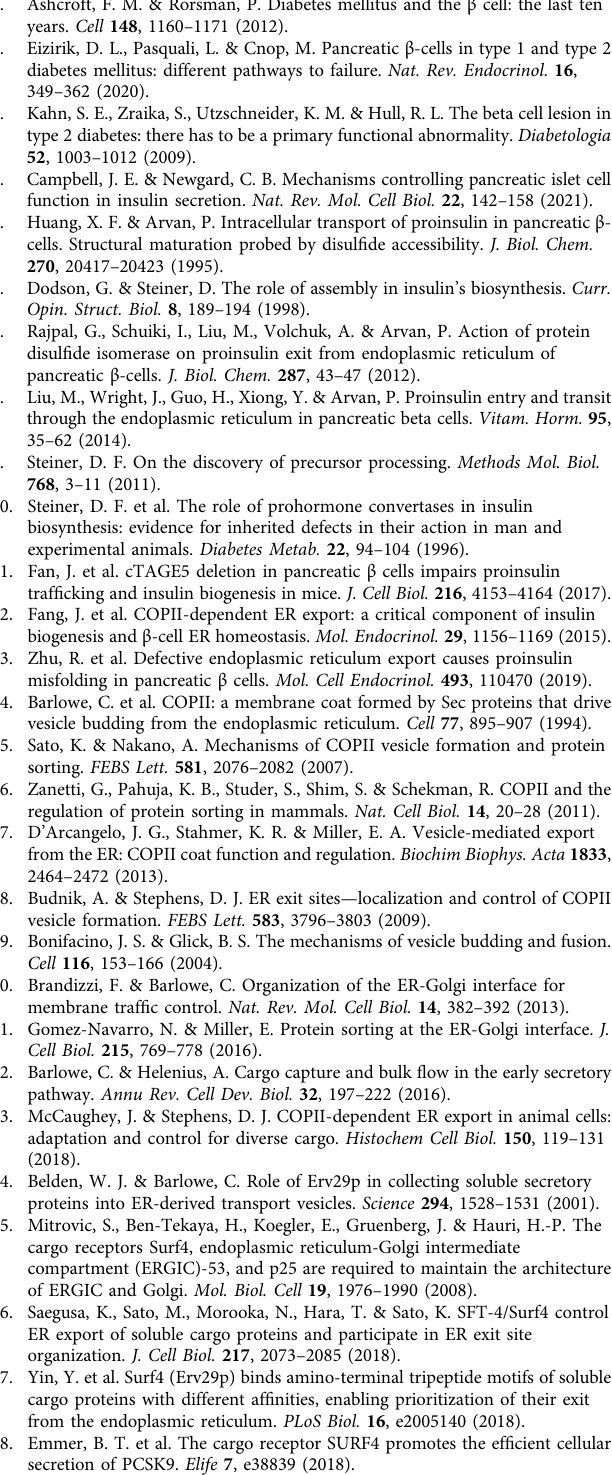
Supplementary Fig. 7. Source data points behind the graphs can be found in the